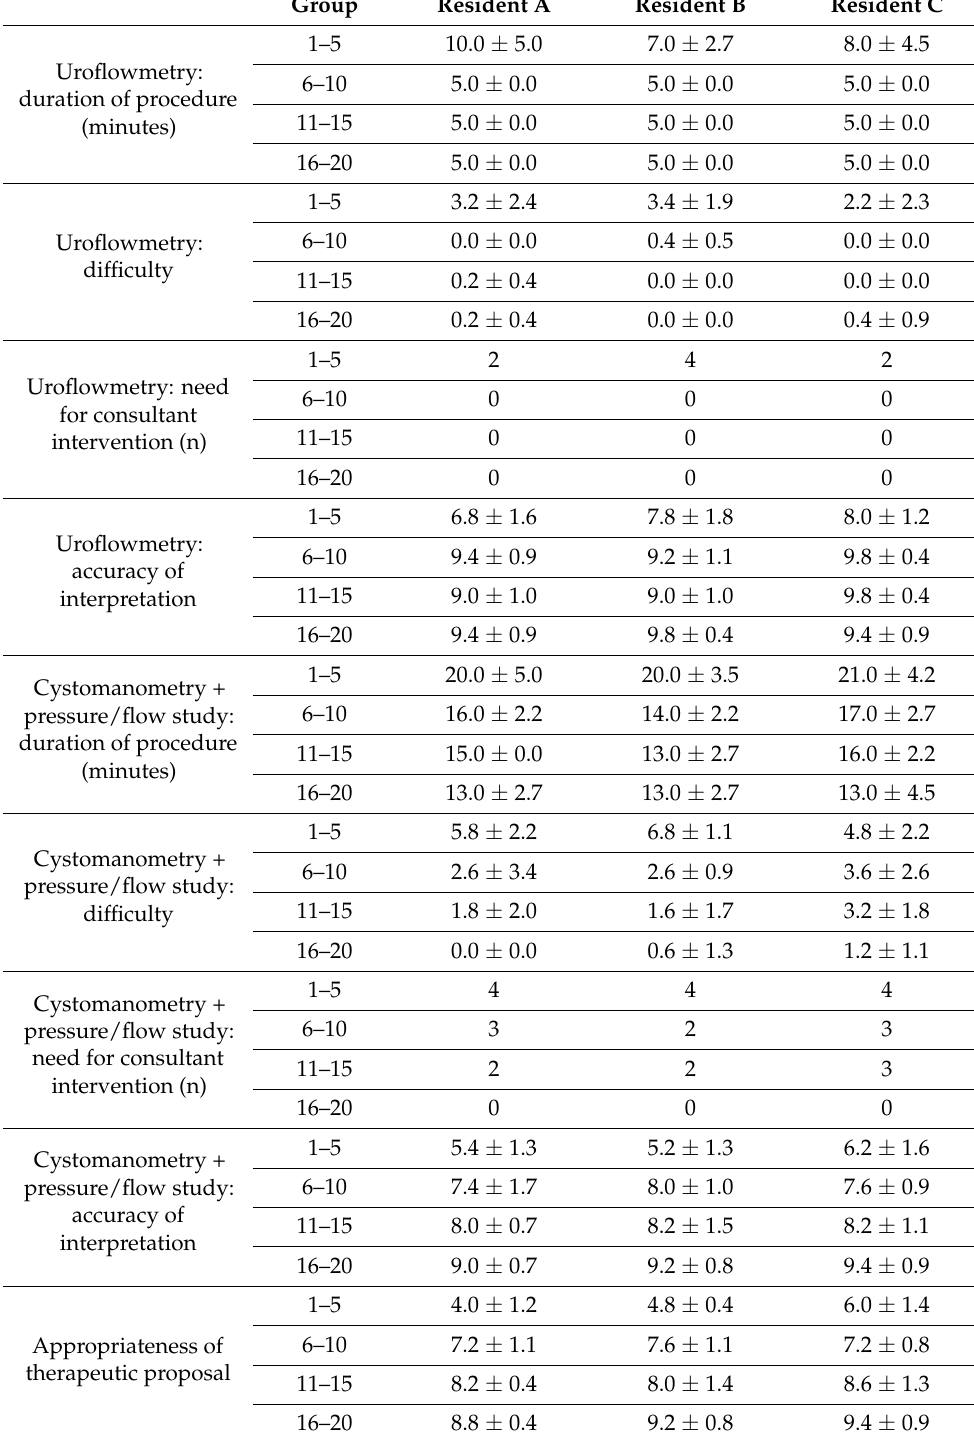
Table 1. Proficiency parameters for each resident analyzed in groups of 5 consecutive procedures. Data as mean ± standard deviation. The difficulty was evaluated with a 10-point VAS scale (0 = very easy, 10 = very difficult). The accuracy of interpretation of the exam was evaluated with a 10-point VAS scale (0 = very inaccurate, 10 = very accurate). The appropriateness of the therapeutic proposal was evaluated with a 10-point VAS scale (0 = very inappropriate, 10 = very